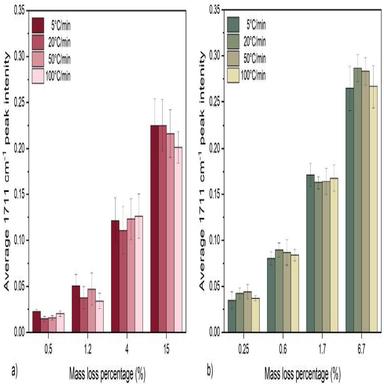
Average intensity and standard deviation of the 1711 cm-1 peak, when PEEK and CF-PEEK are heated with 5, 20, 50 and 100 ◦C/min upon a mass loss of: a) 0.5%, 1.2%, 4%, 15% and b) 0.25%, 0.6%, 1.7%, 6.7% respectively.